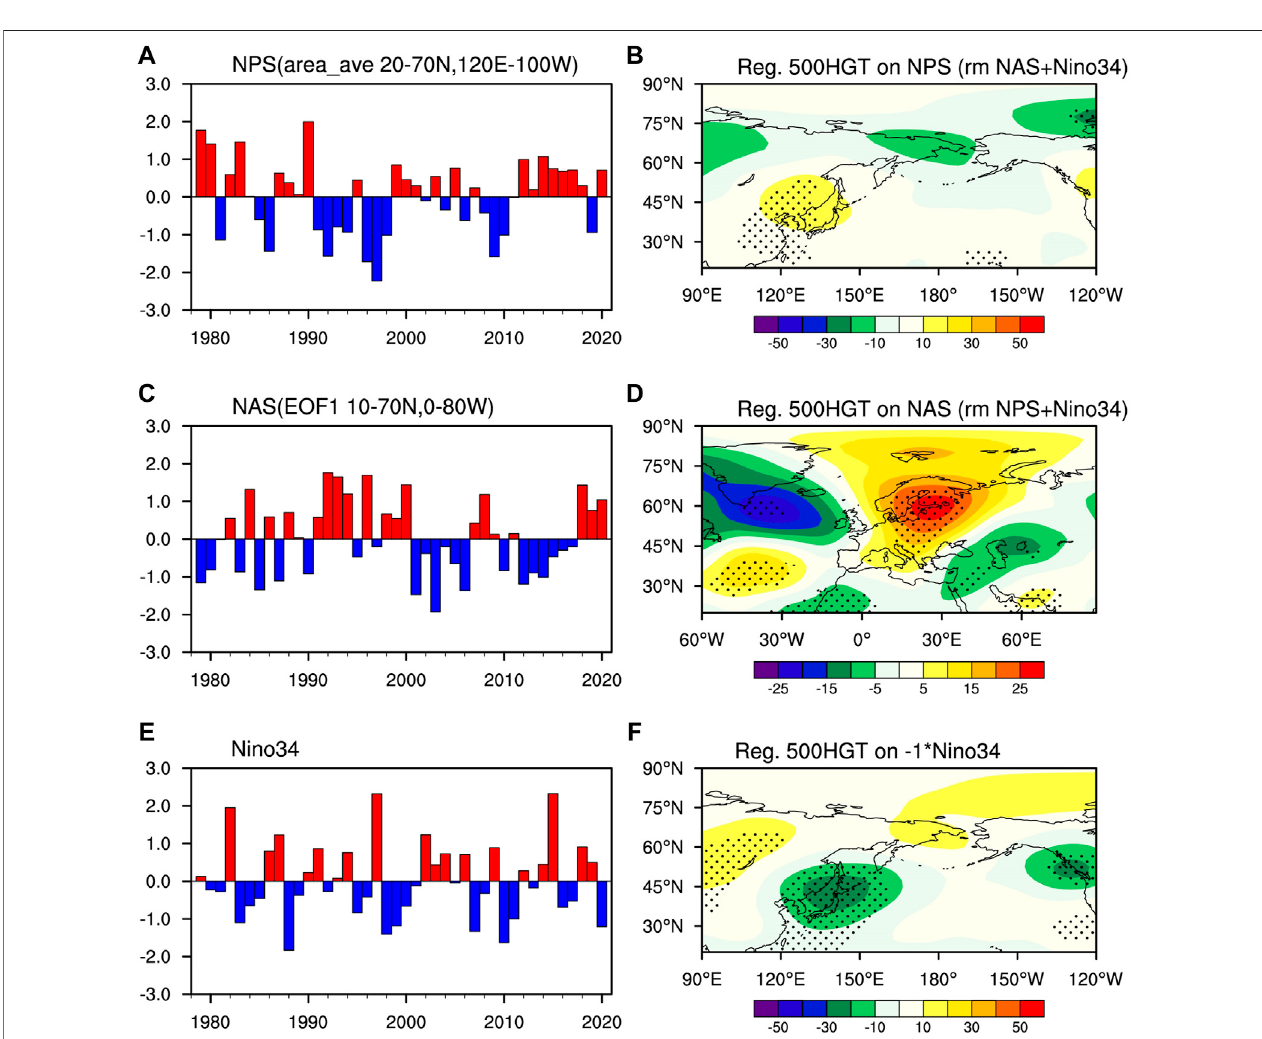
FIGURE 10 | Normalized time series of the October (A) North Paci fi c SST index, (C) North Atlantic SST index, and (E) Niño3.4 index. Partial correlations of the October (B) North Paci fi c SST index, (D) North Atlantic SST index, and (F) Niño3.4 index (multiply by − 1) with the November 500-hPa HGT during 1979 – 2020. Regions above the 90% signi fi cance level are